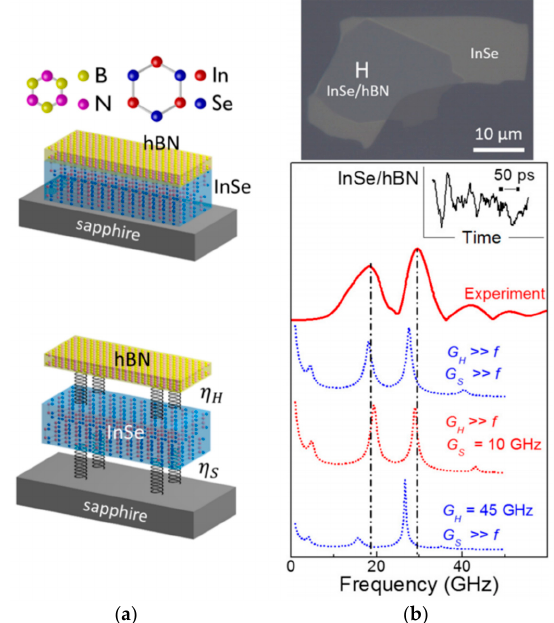
Figure 10. ( a ) Schematic representation of a stack of hexagonal boron nitride (hBN) and InSe crystal on top of sapphire substrate, with introduction of imperfect contacts defined by fitted stiffness. ( b ) (top) Optical micrograph of the stack and (bottom) corresponding spectral density in solid red line extracted from the time-domain measurement in inset. Models in dashed lines find a better match with data in the case of perfect hBN/InSe contact and relatively bad contact with substrate (red dashed line). From [137], published by the American Physical Society under Creative Commons.